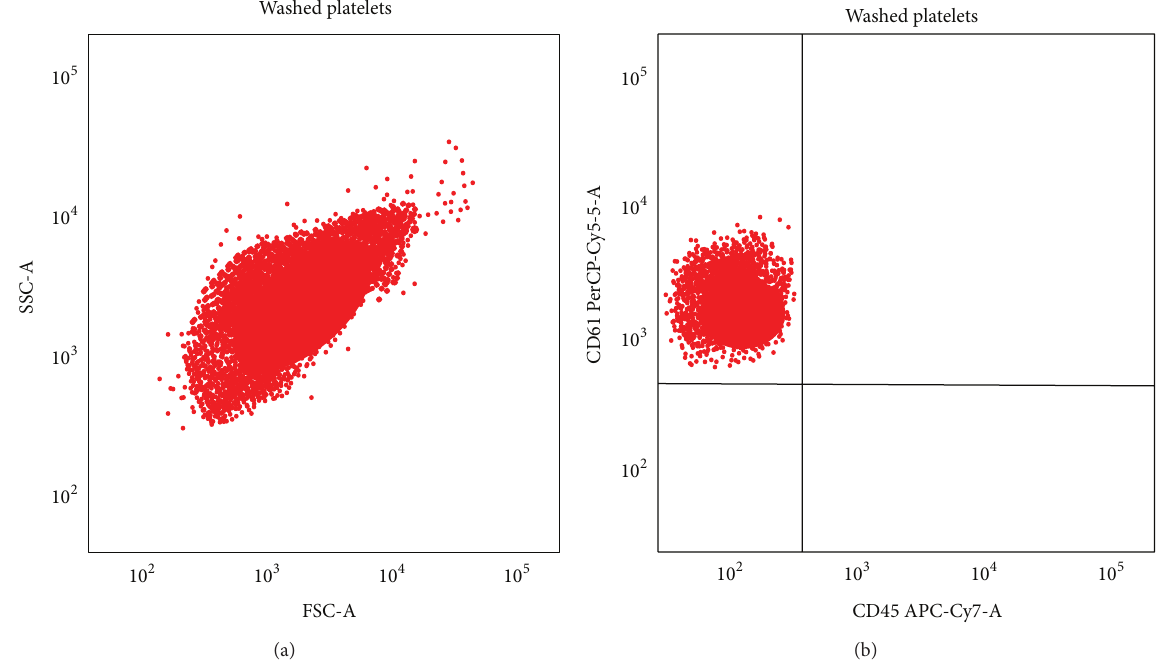
Figure 1: Flow cytometric determination of white blood cell (WBC) contamination of platelet suspensions. Flow cytometric analysis after staining with antibodies specific for CD61 (PerCP-Cy5-5) and for CD45 (APC-Cy7). In (a), the box includes cellular suspension according to SSC and FSC. In (b) the CD61+/CD45+ events gated on P1 are shown in the right upper